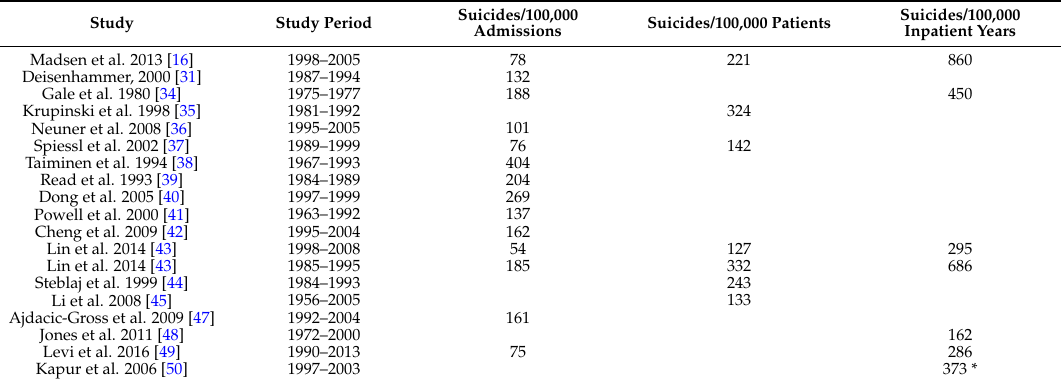
Table 1. Rates of inpatient